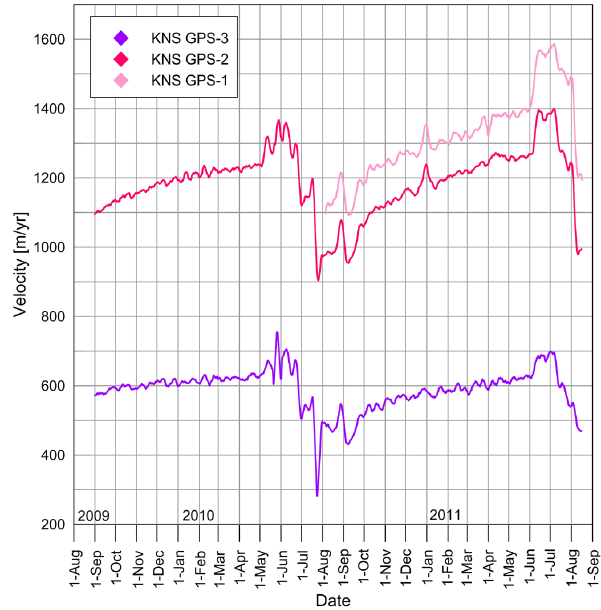
Figure 3. Sermilik Bræ 7-day averaged GPS velocities (see Fig. 1 and Table 1 for instrument position and operational period).